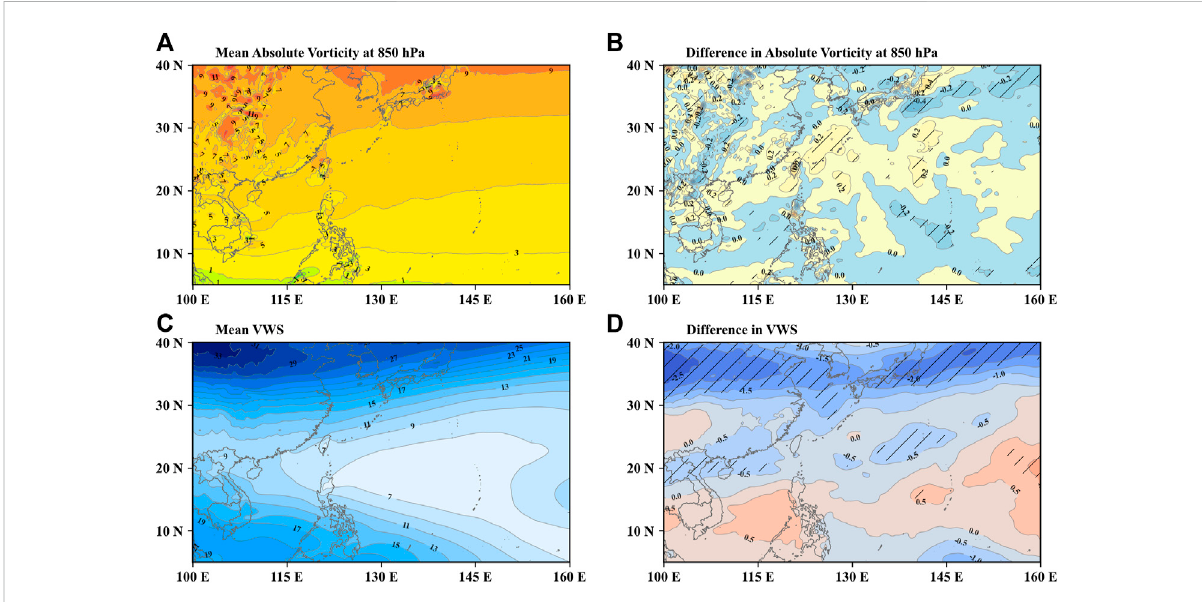
FIGURE 7 The same as Figure 6, but for (A,B) absolute vorticity at 850 hPa (10 – 5 s − 1 ) and (C,D) VWS (m s − 1